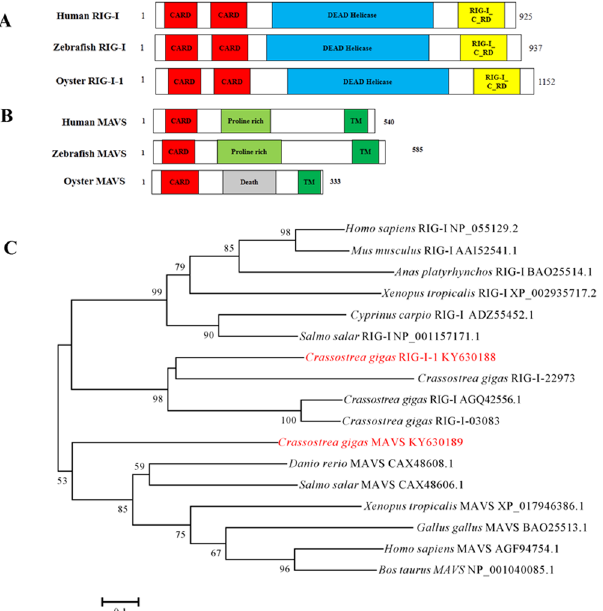
Figure 2. Sequence analysis of CgRIG-I-1 and CgMAVS. ( A ) Domain topology of CgRIG-I-1 compared with human RIG-I and zebrafish RIG-I. CARD: Caspase activation and recruitment domain, RIG-I-C-RD: C-terminal regulatory domain of RIG-I. ( B ) Domain topology of CgMAVS compared with human MAVS and zebrafish MAVS. TM: Transmembrane domain. ( C ) Neighbour-joining tree of RIG-I and MAVS was constructed using protein sequences of CARD domains. The numbers at nodes indicate bootstrap values. The phylogenetic tree was built with Mega v5.05. The neighbour-joining method was used to calculate the trees, with 1000 bootstrap